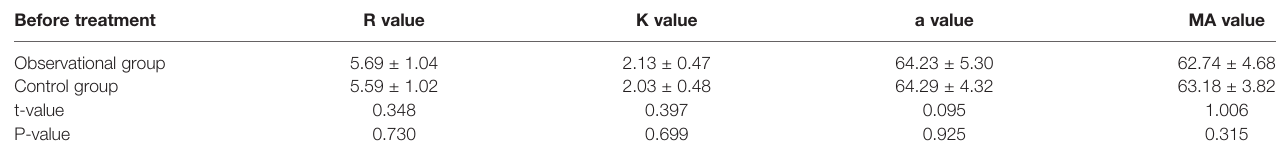
TABLE 2 | Comparison of parameters of pre-treatment thromboelastography between the two groups of patients (mean ± standard deviation). Before treatment R value K value a value MA value Observational